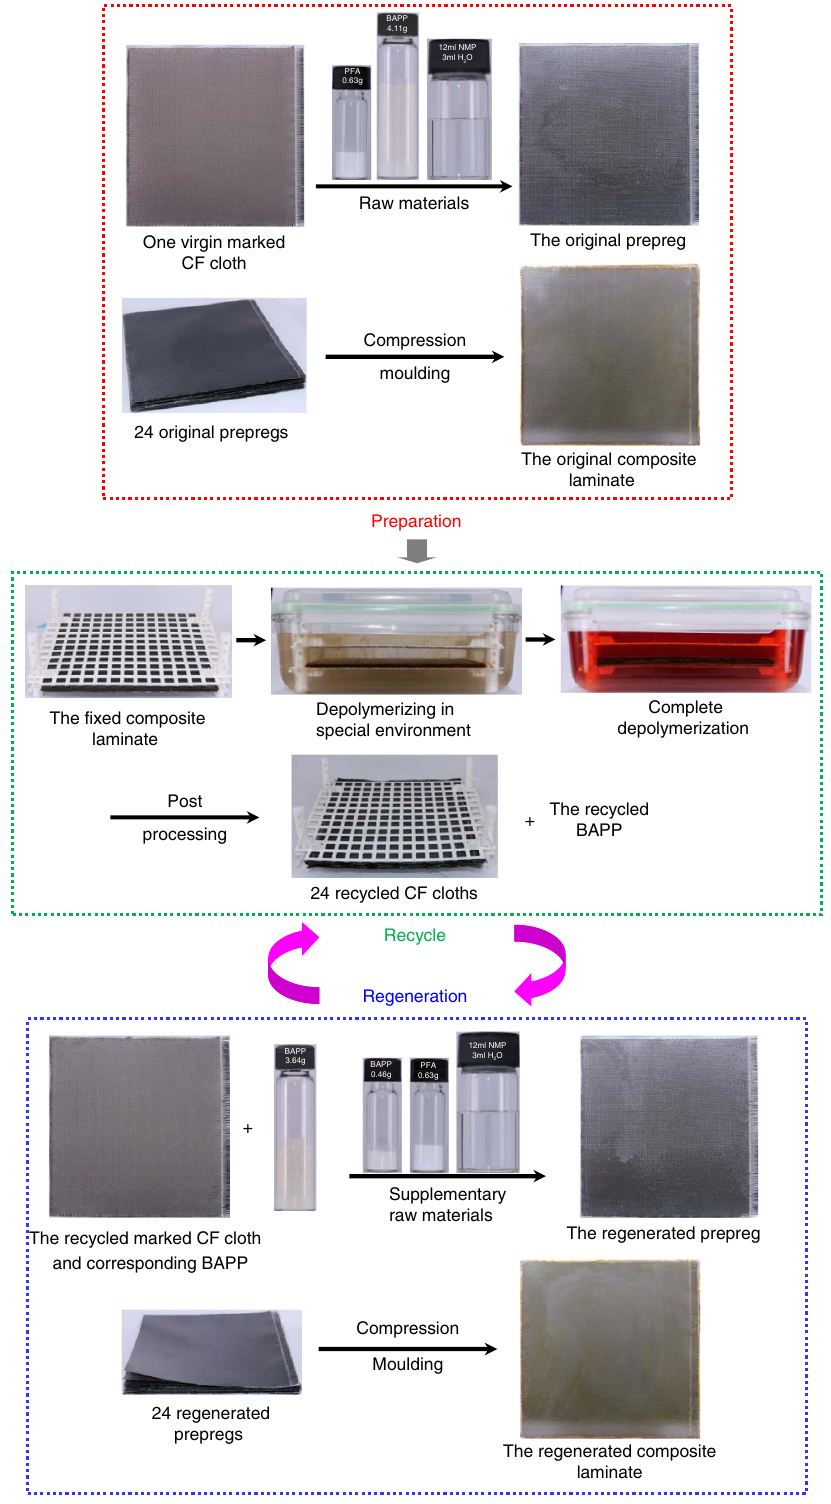
Figure 1 | The recycle and regeneration processes of the CF/PHT composite. A total of 24 virgin plain weave CF cloths (20 (cid:4) 20cm) were used to prepare the prepreps, and one virgin CF cloth with irregular edges and a white lock glass line is used as the outermost layer of the composite laminate to clearly trace the whole